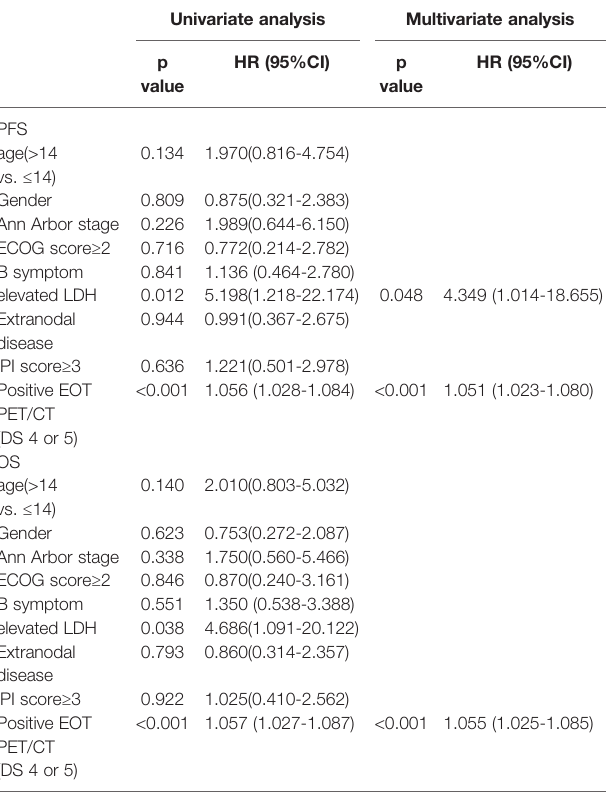
TABLE 2 | Univariate and multivariate analyses for PFS and OS. Univariate analysis Multivariate analysis